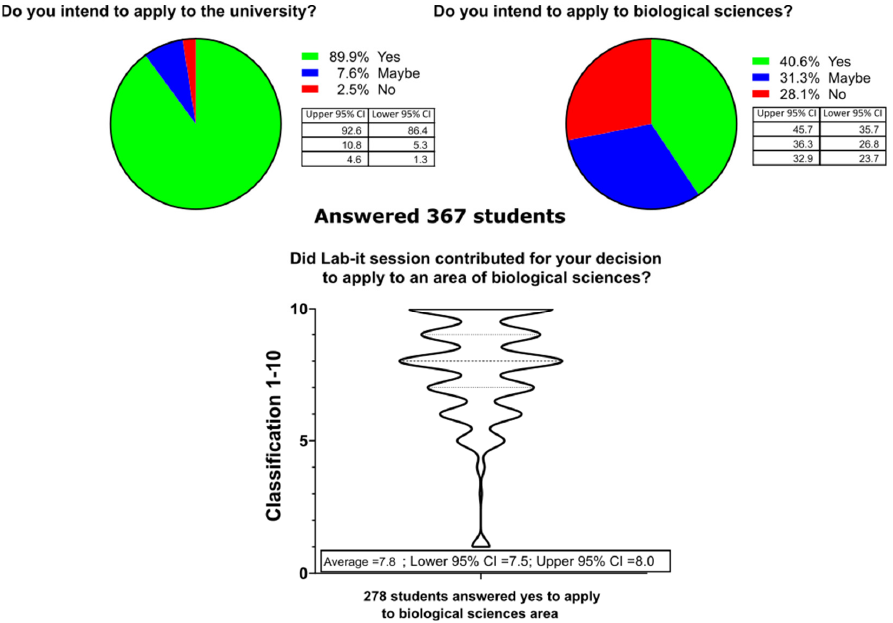
Figure 4. Understanding if students want to proceed with studies in the university and if the